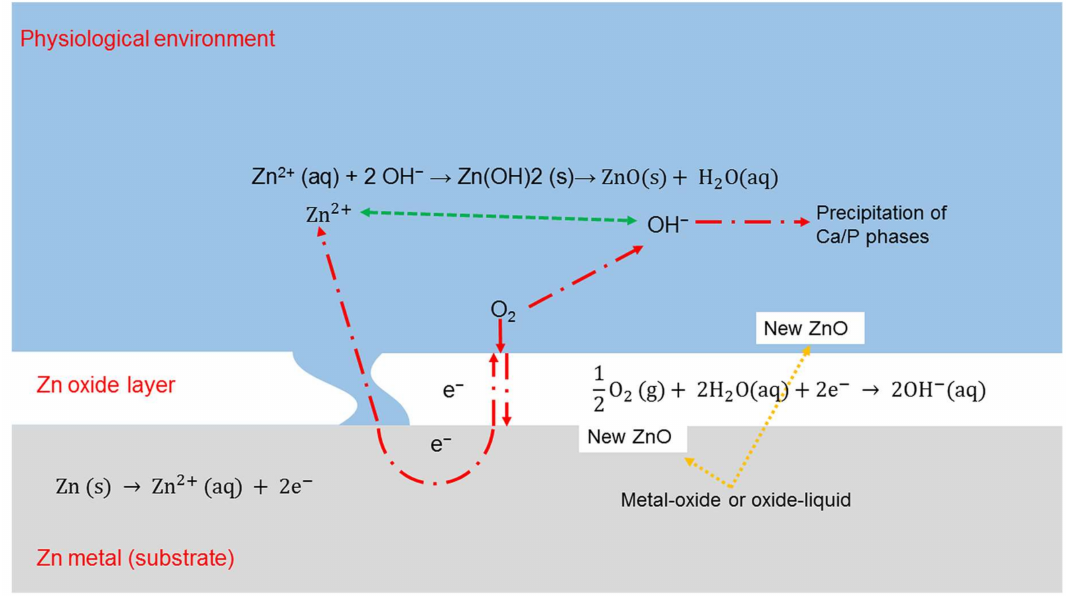
Figure 3. Schematic diagram of degradation mechanism of Zn in a physiological